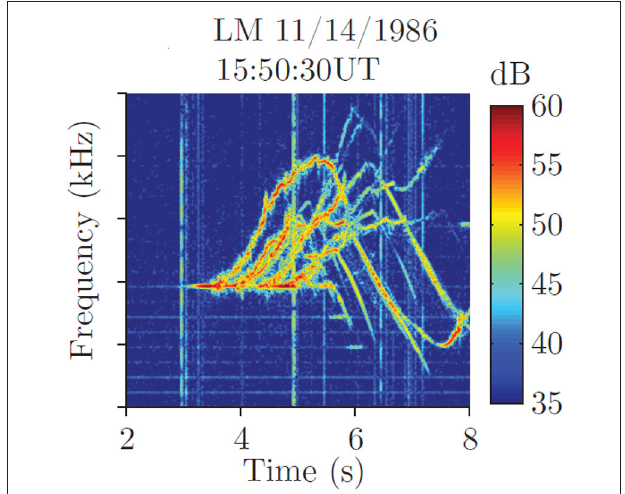
FIGURE 4 | Complex triggered emissions observed at Lake Mistissini in response to Siple Station transmissions showing multiple risers and hooks. Adapted from Figure 2 of Li et al.